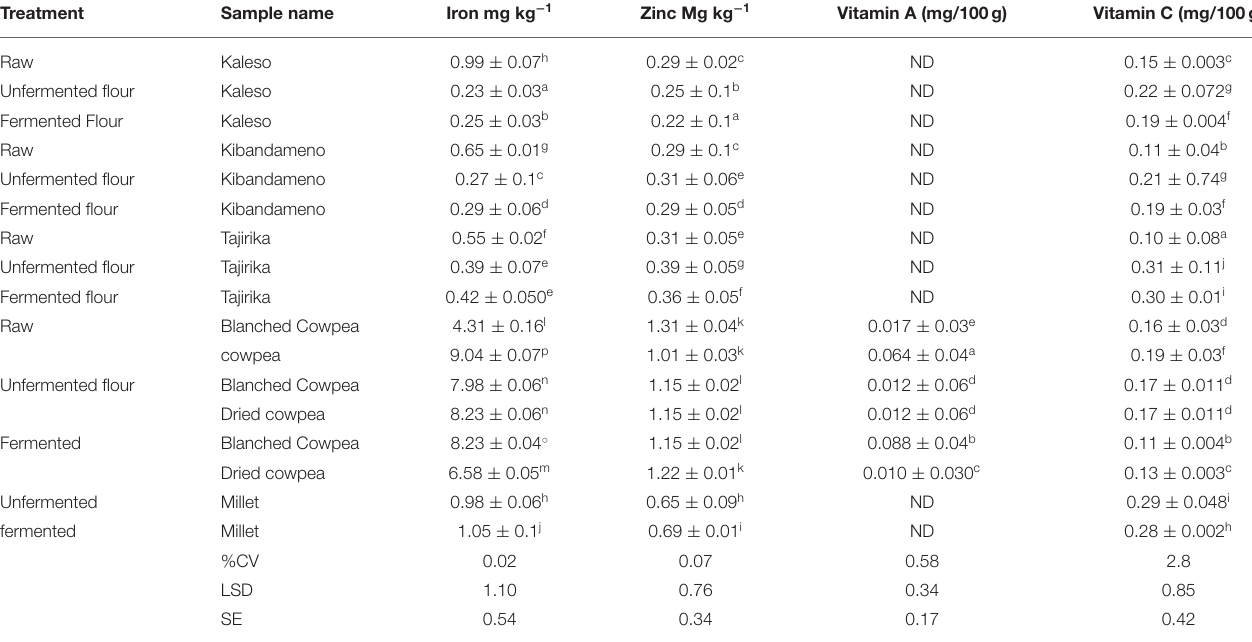
TABLE 2 | Effect of pre-treatment processing on the mineral and vitamin content of raw, unfermented flour and fermented flours of cowpea leaves, millet, and cassava roots.